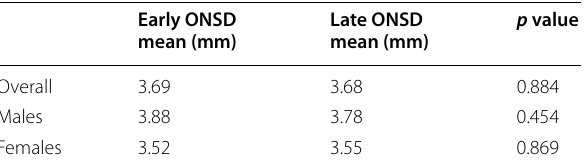
Table 1 Welch two sample t test comparing mean of early versus late mean ONSD measurements using subject 21 as a cutoff Early ONSD mean